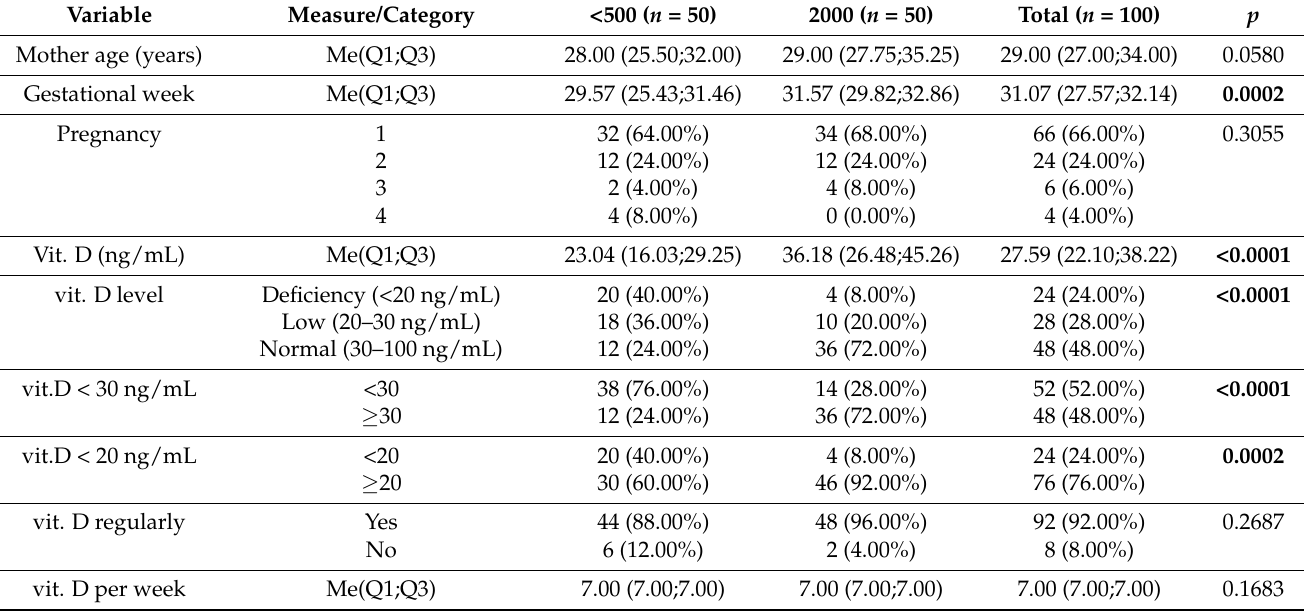
Table 1. Comparison of baseline characteristics of patients supplementing vitamin D at the dose of 2000 IU recommended by the Polish Society of Gynecologists and Obstetricians versus patients supplementing vitamin D at a dose found in the majority of supplements for pregnant women, i.e., below 500